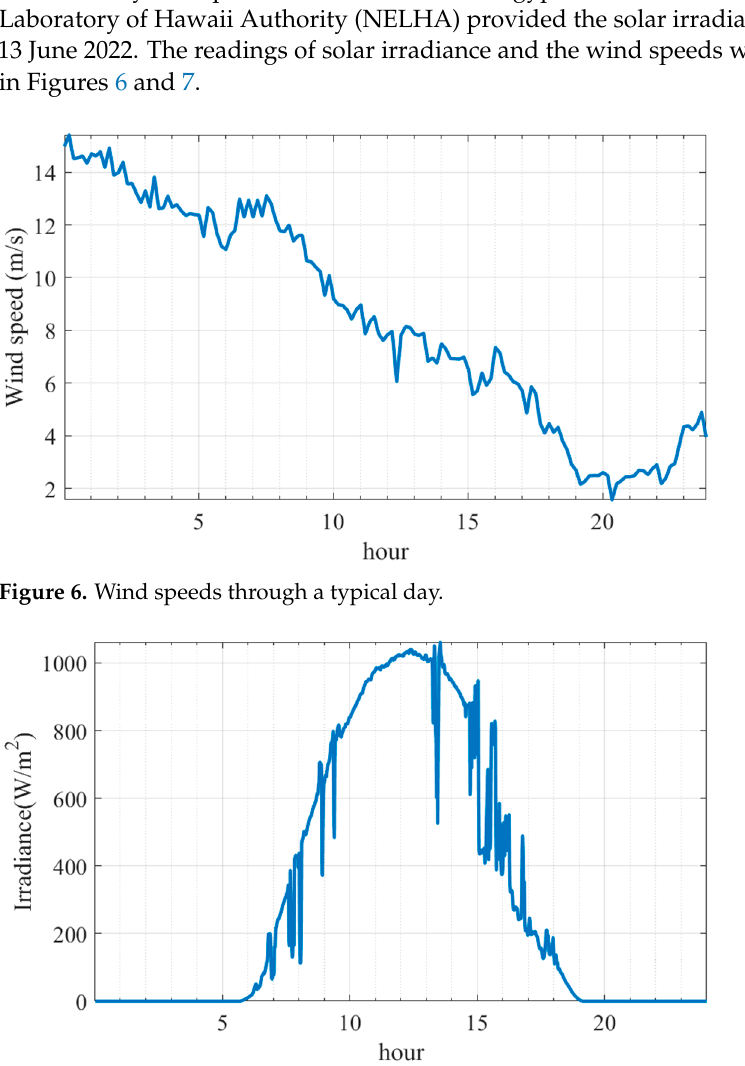
Figure 7. Solar irradiance through a typical day.